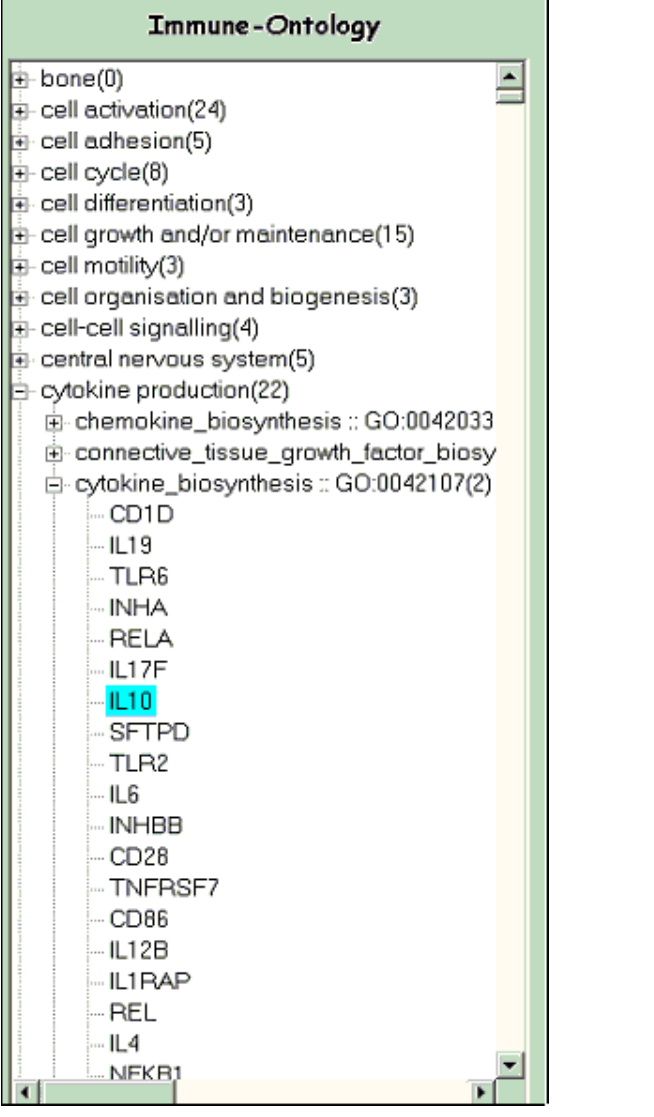
Figure 3. The Immune-Ontology to identify immunology/haematology related processes. The IL10 gene from the microarray gene list has functionality in cytokine production. More specifically, it plays a role in cytokine biosynthesis